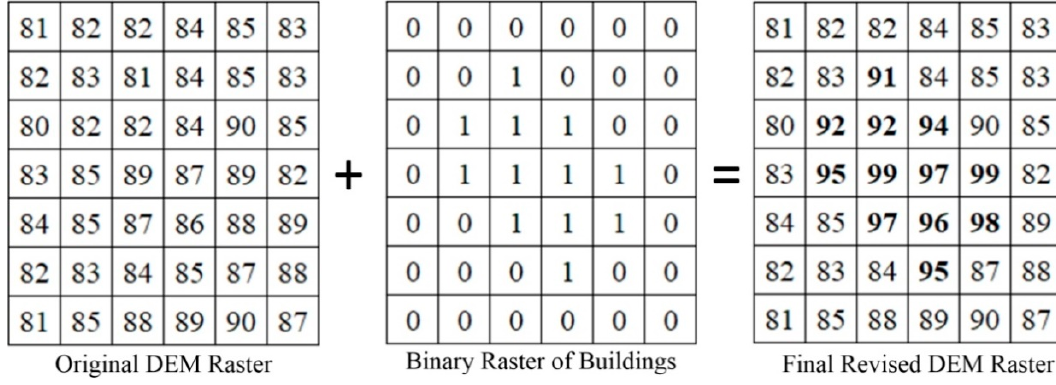
Figure 1. The process of urban terrain modification.